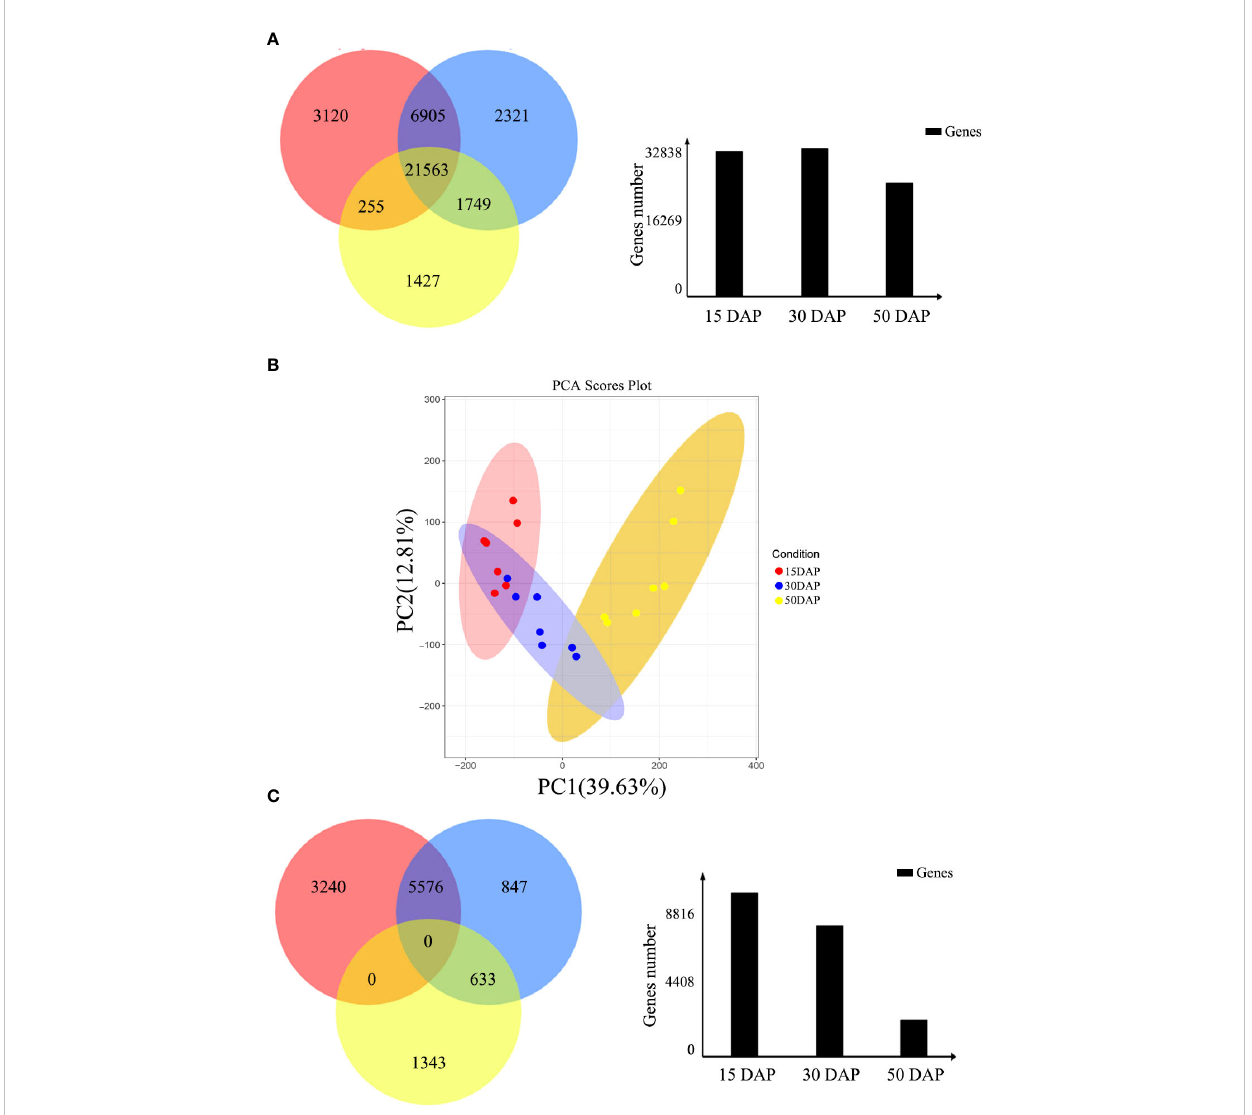
FIGURE 1 Identi fi cation of differentially expressed genes during seed development. (A) Venn diagram of the number of genes expressed during seed development. The red, blue, and yellow circles represent the early, middle, and late stages of seed development, respectively. The numbers represent the number of genes. The bar chart shows the total number of genes expressed during the early (15 DAP), middle (30 DAP), and late (50 DAP) stages of seed development. (B) Cluster dendrogram showing three distinct developmental stages: the early, middle, and late stages of seed development. (C) Venn diagram of DEGs expressed during seed development. The red, blue, and yellow circles represent the early, middle, and late stages of seed development, respectively. The numbers represent the number of DEGs. The bar chart shows the total number of DEGs expressed during the early (15 DAP), middle (30 DAP), and late (50 DAP) stages of seed